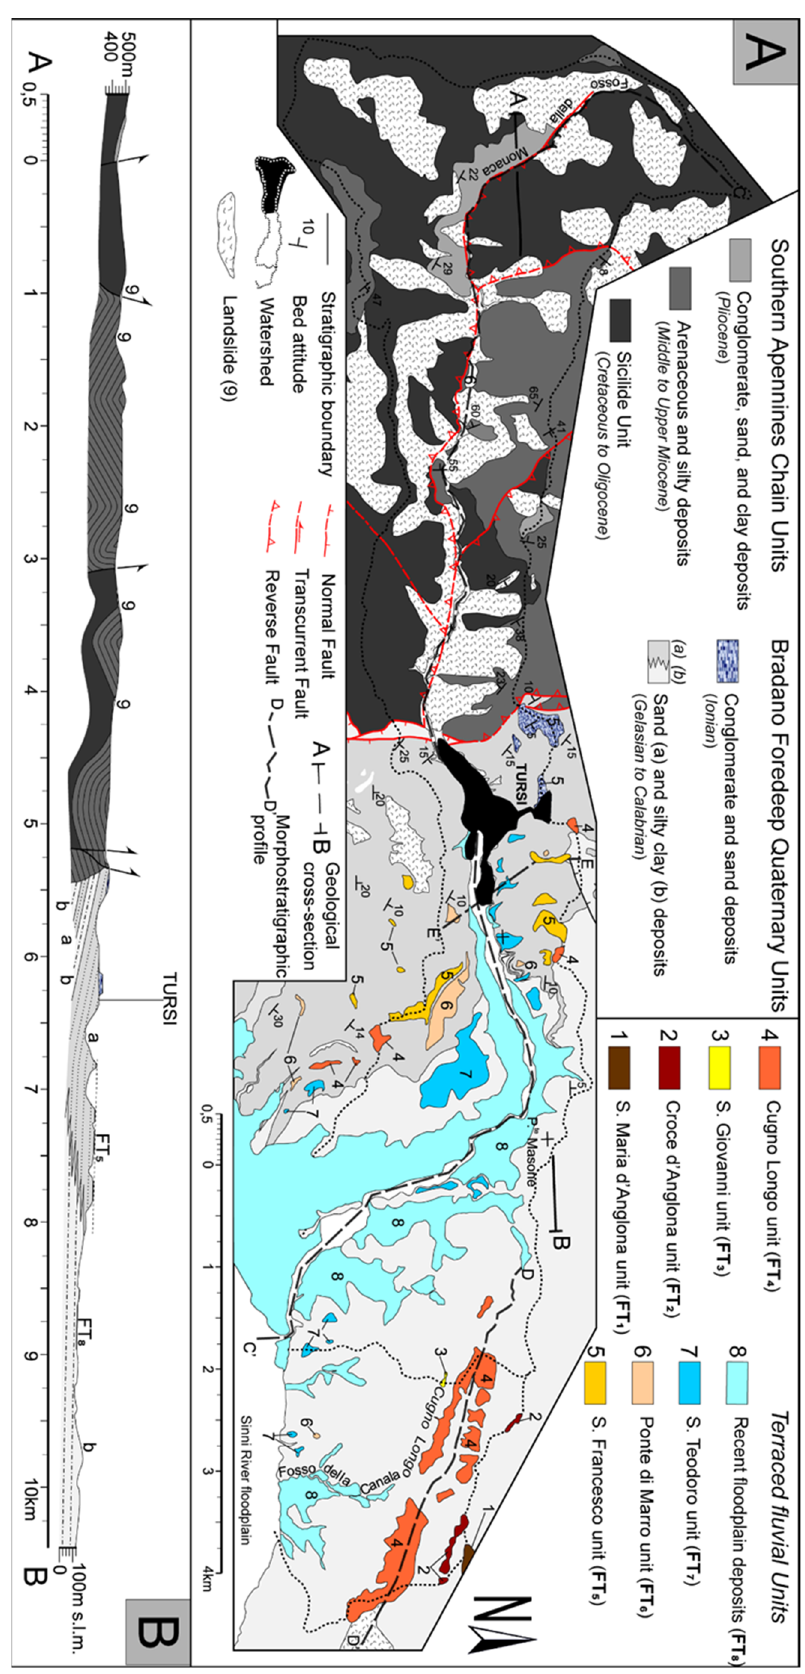
Figure 3. Geological map of the fluvial terraces outcropping in the Pescogrosso catchment and surrounding areas ( A ). Geological cross-section trough the studied area ( B ). See Figure 1 for location.